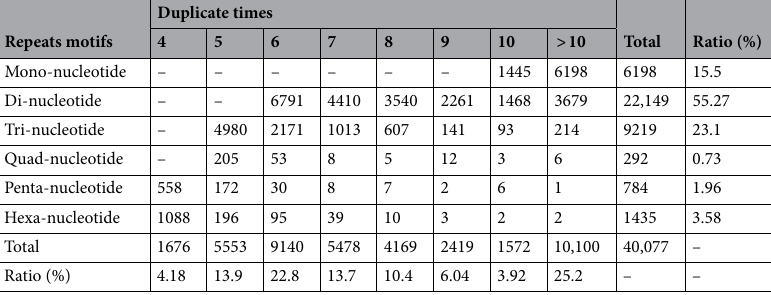
Table 1. Transcriptome SSR repeat type and